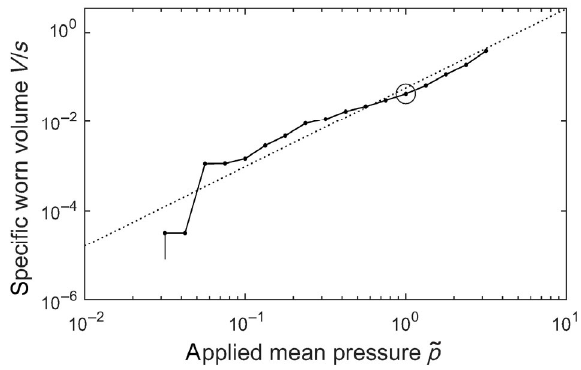
Fig. 12 Dependency of the wear volume per distance as a function of the applied external load. Parameters as in Fig. 4.